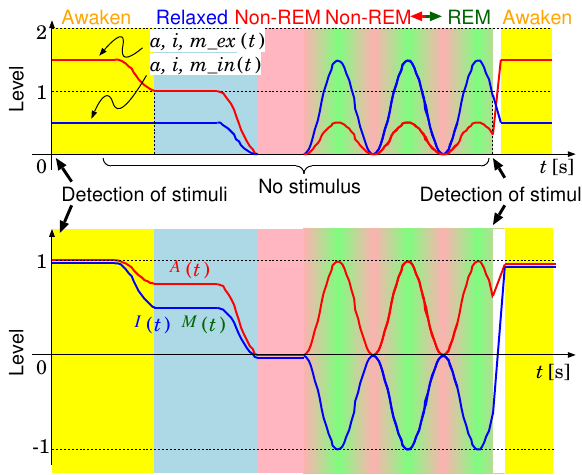
Figure 6. Variations of A , I , M and their sub-elements with time.